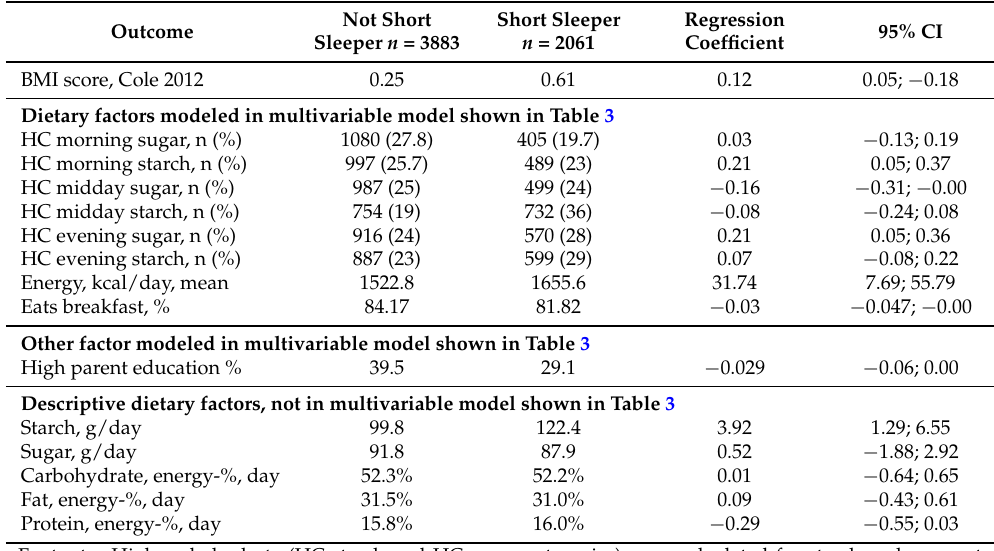
Table 2. Cross-sectional baseline characteristics of short sleepers (<10 h). The right-hand columns present the regression coefficients, with 95% CI (Confidence Interval).